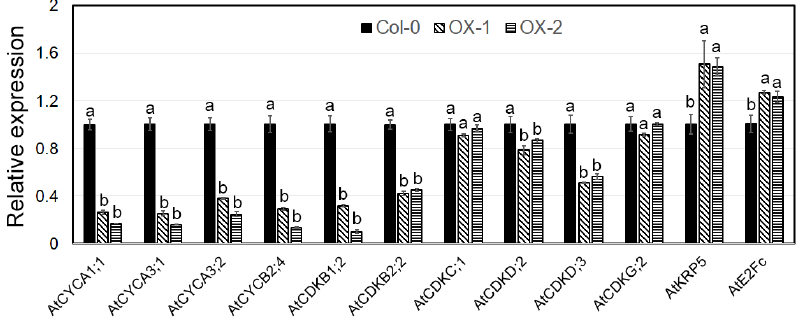
Figure 7. The effect of constitutively expressing CnTCP4 in A. thaliana on the transcription of cell cycle marker genes. Col-0: wild-type plants; OX-1, OX-2: transgenic plants. Values shown as mean ± SE (n = 3). Columns headed by a different letter denote transcript abundances differing significantly ( p < 0.05) from the transcript abundance measured in Col-0 plants.